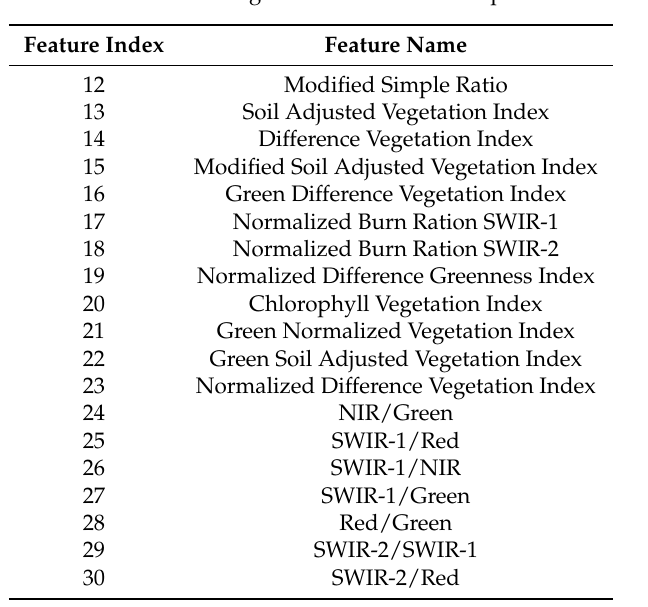
Table 2. The list of used vegetation indices and simple band